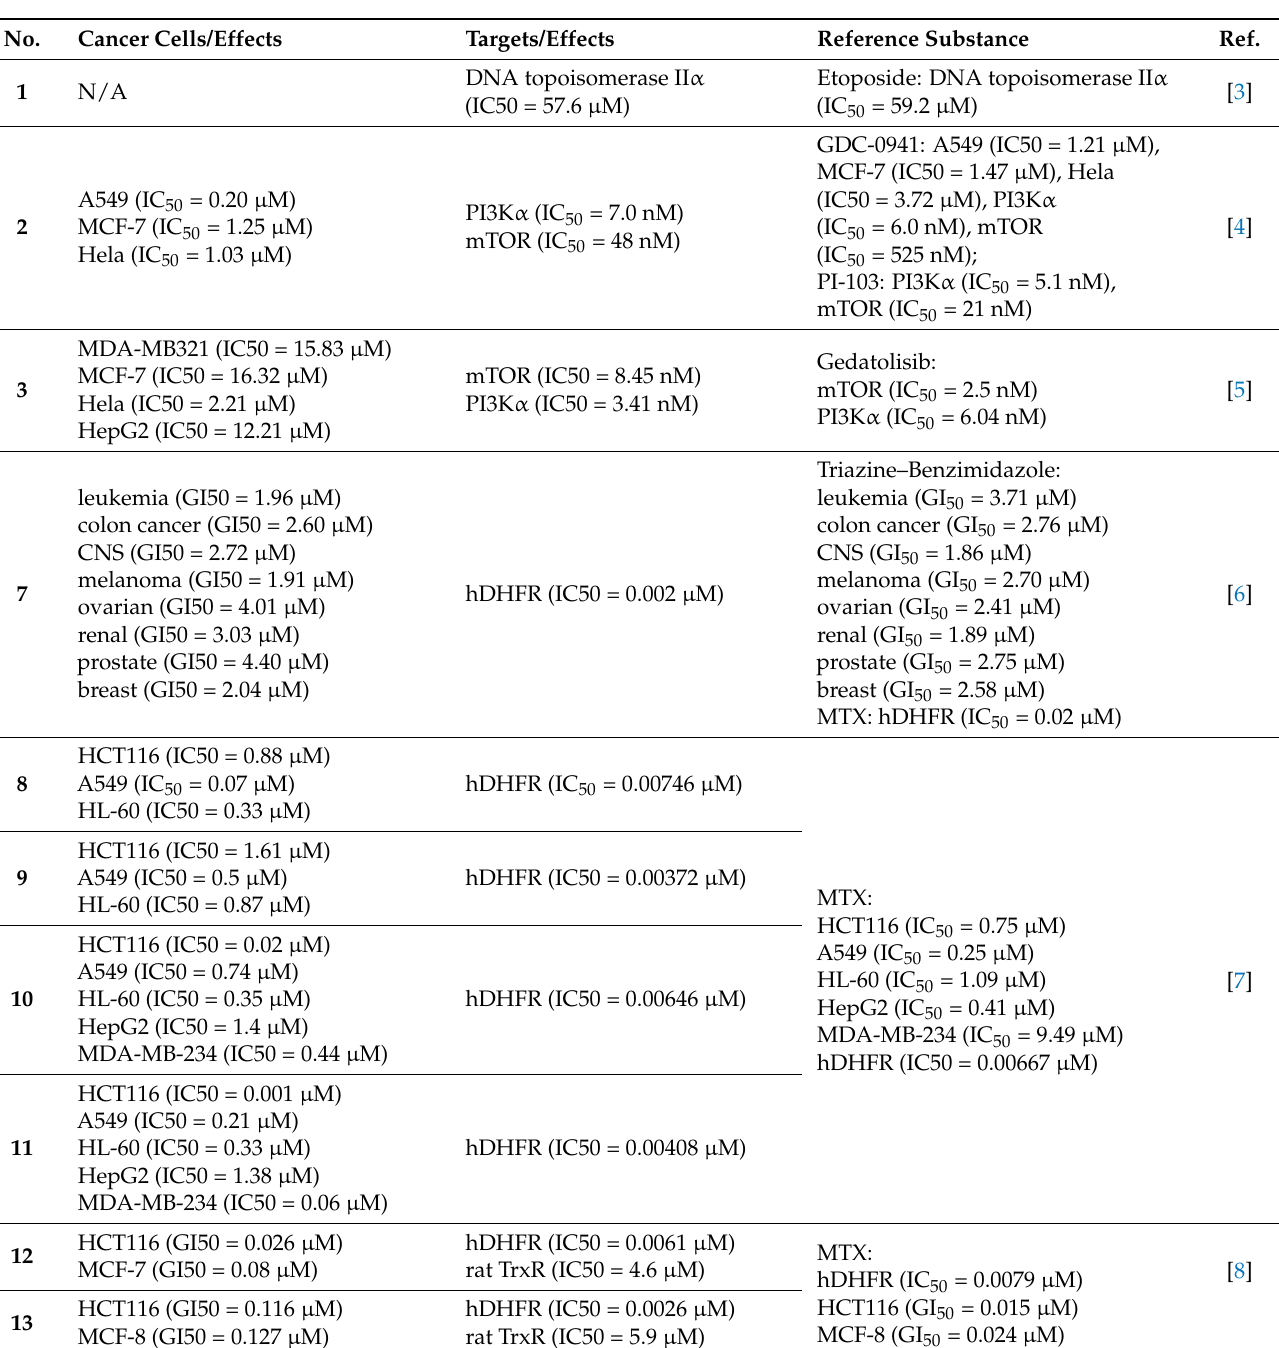
Table 1. Promising effects of 1,3,5-triazine derivatives on cell lines and/or enzymes. N/A; not